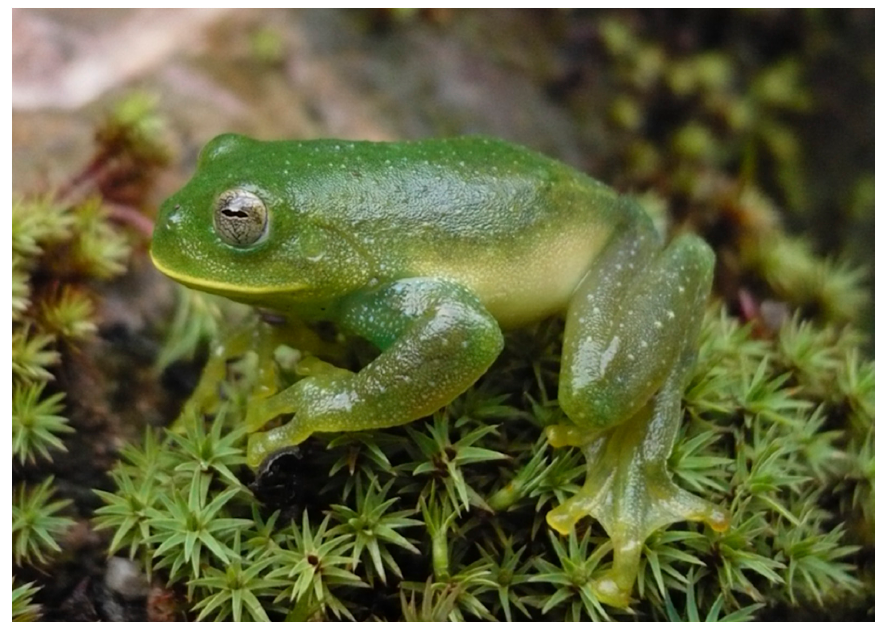
Figure 32. Centrolene condor in life. Ecuador, Zamora Chinchipe province, Paquisha, EPN 11343. Photo by Ana Almendáriz.